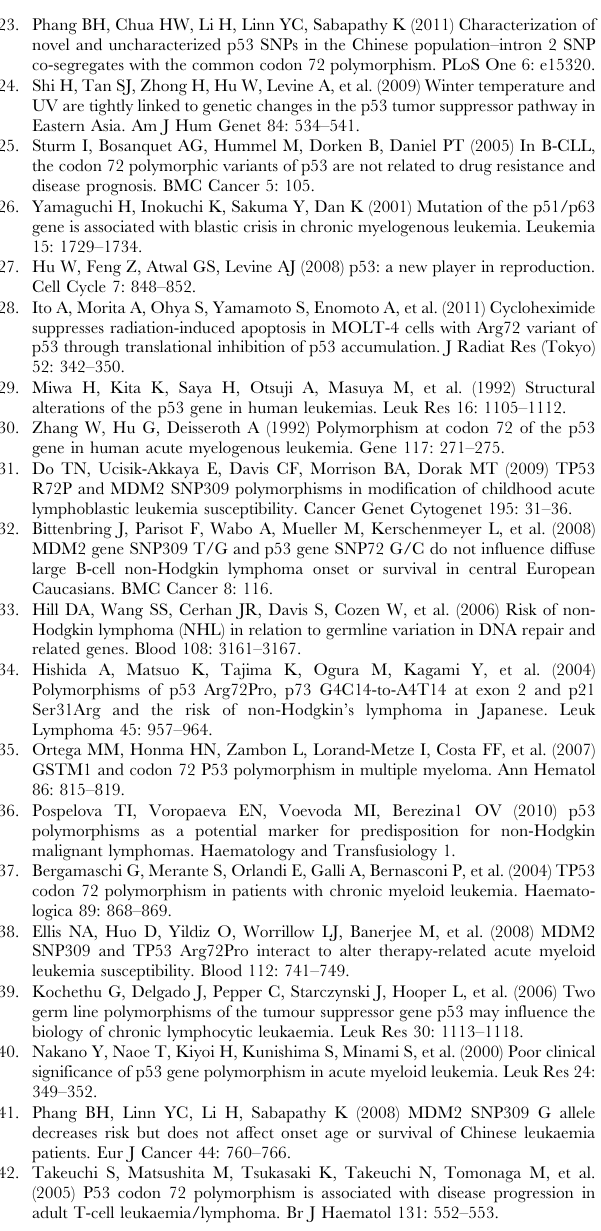
Table S3 Meta-regression